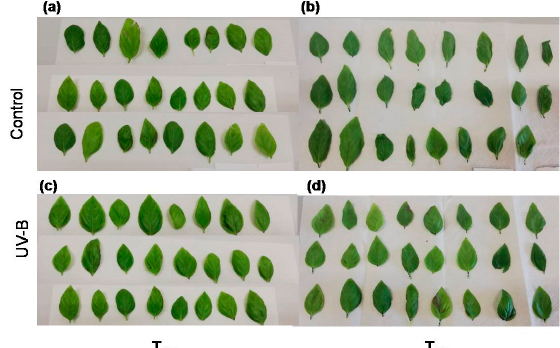
Figure 5. Pictures of O. basilicum leaves from the control ( a , b ) and UV-B treatments ( c , d ) at T S0 ( a , c ) and at T S7 ( b , d ).